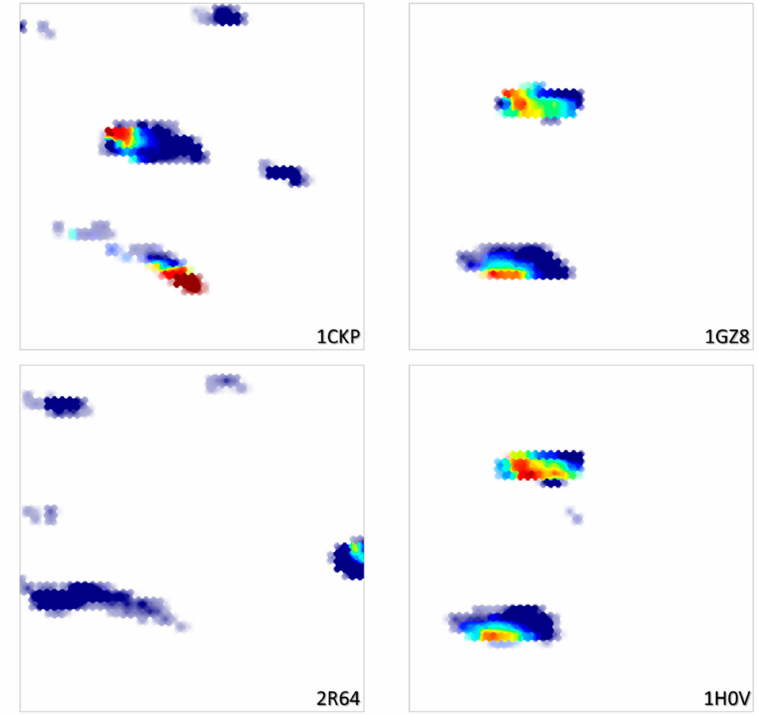
Figure 3. RMSD landscapes on the Hy map for four ligands also shown in Figure 2. Note how the similar ligands 1GZ8 and 1H0V cover the same map zones, whilst the structurally distinct 1CKP and 2R64 each claim their specific